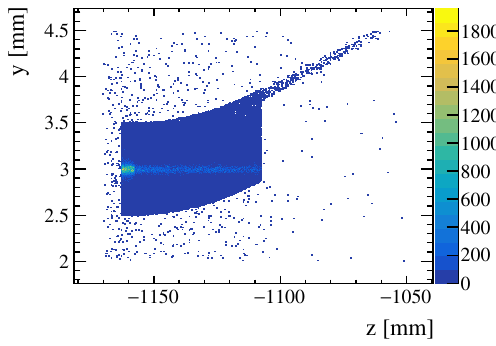
Fig. 11 Radiography of the W target and Ge crystal geometries in Geant4 , shown in the zy view. The distribution represents the ori- gin vertex for stable charged particles from different physics processes (Compton, δ rays, hadronic interactions and pair production). The pres- ence of the Λ + c decay vertex after the crystal is clearly visible